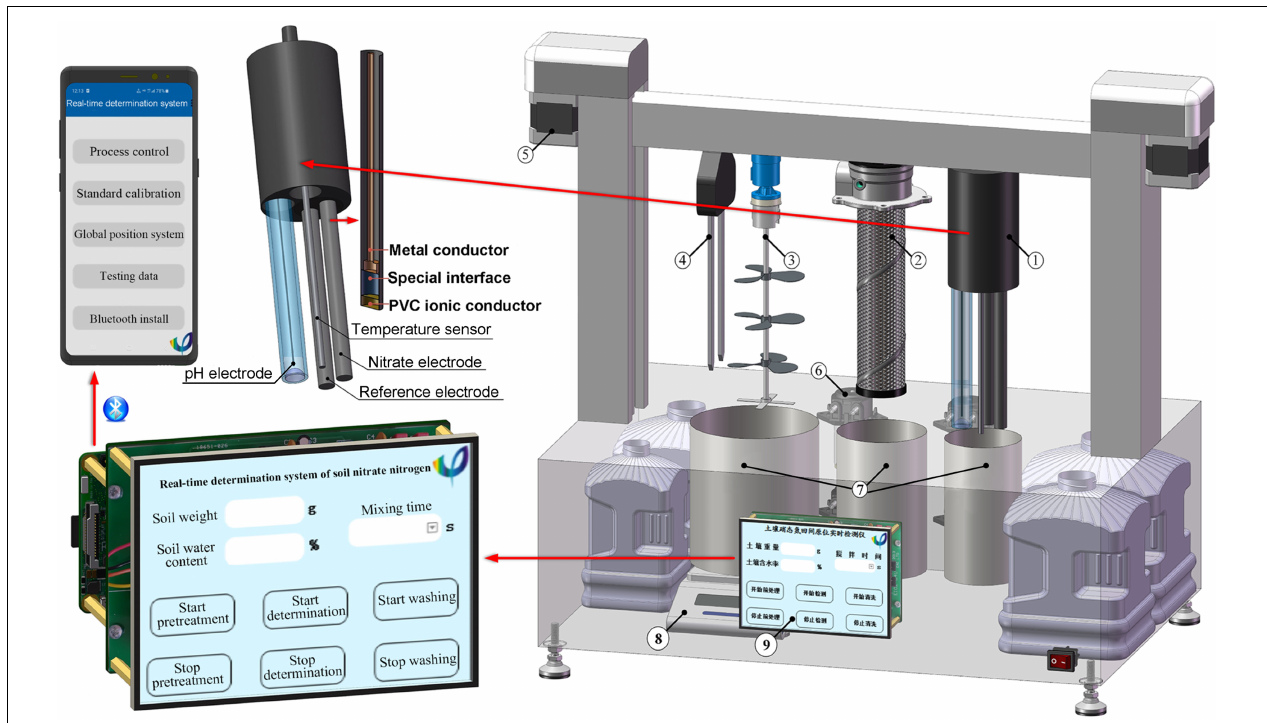
FIGURE 2 | Scheme and profile of the cooperative measurement system: (1) Combination electrode array, (2) Filter, (3) Stirrer, (4) Soil water content sensor, (5) Stepper motor, (6) Peristaltic pump, (7) Sample cell, (8) Electronic scale, and (9) LCD touch